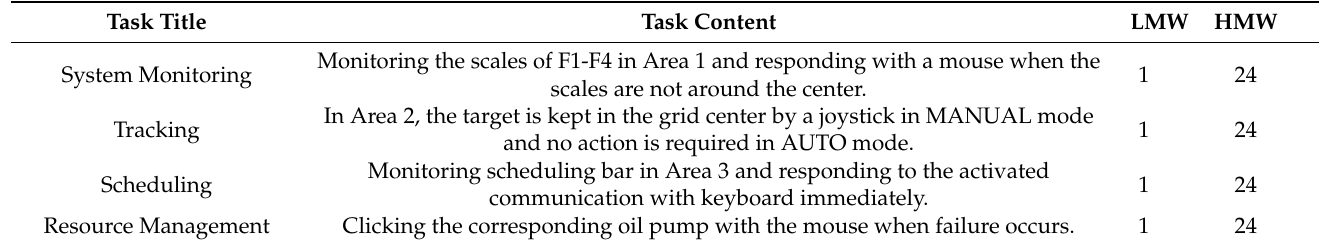
Table 1. Frequency of occurrence of four